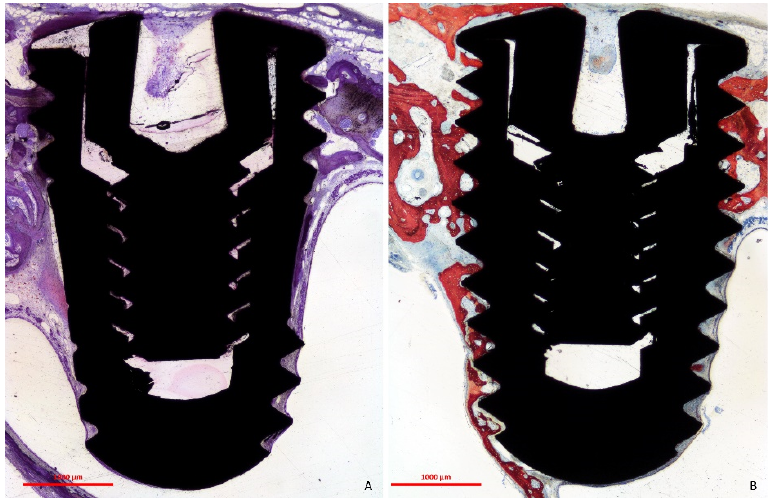
Figure 5. Photomicrographs of ground sections. ( A ), collapse of the sinus mucosa around the implant body with little bone formation from the nasal bone towards the implant apex. ( B ), note bone integration on the implant surface in contact with the medial bone wall of the sinus. ( A ), Toluidine blue stain; ( B ), Stevenel’s blue and Alizarin red.